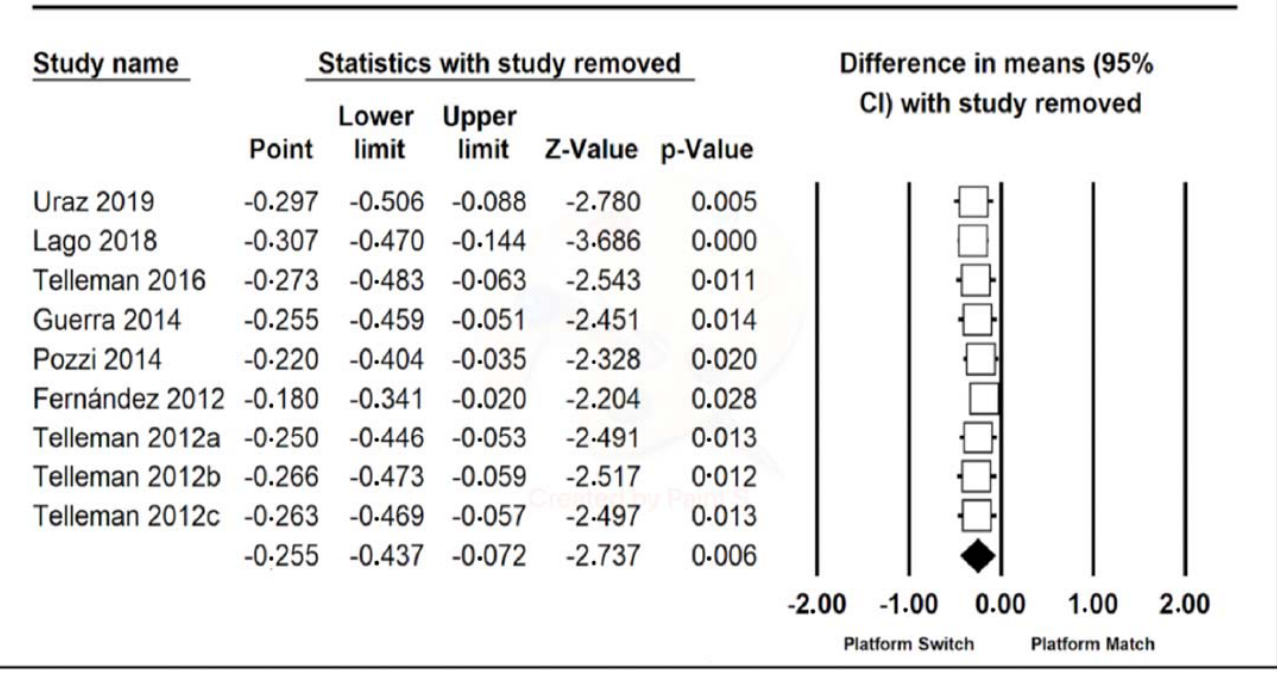
Figure 3. One Study Remove of peri-implant bone loss.